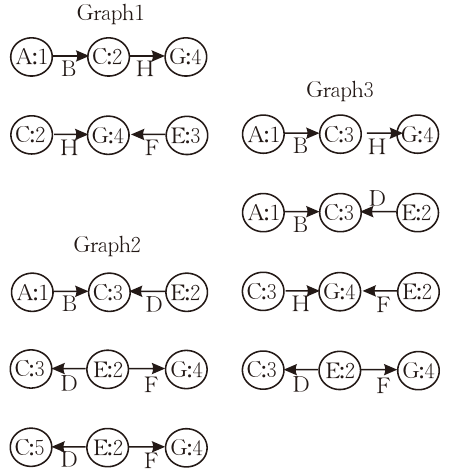
Fig. 22 Double edge subgraphs that meet